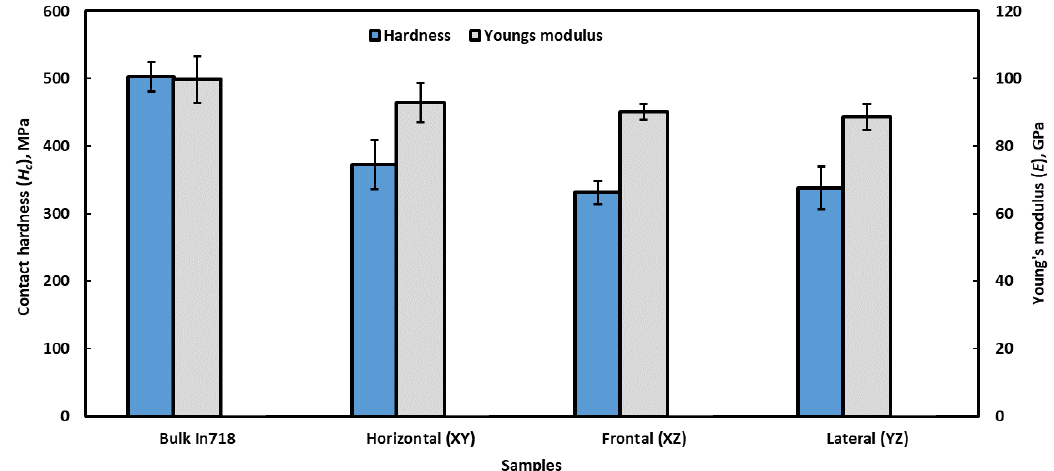
11 of 16 Figure 9. Representative load–displacement graphs on different plans of L-PBF and cast Inconel 718 alloy. A number of mechanical properties of the investigated alloys, such as contact hard- ness ( H c ) and Young’s modulus ( E ), were obtained by analyzing the unloading portion of the load–displacement curves [37], as shown in Figure 10 and also reported in Table 1. Both the hardness and Young’s modulus of the L-PBF-processed alloy are somewhat lower than those of cast alloy. Among different planes of the L-PBF-processed alloy, the horizontal plane exhibits a marginally higher properties than the frontal and lateral planes. This can be attributed to the microstructural evaluation of the L-PBF-processed alloy. In accordance with the microstructural arrangement, as reported in Section 3.1, dur-